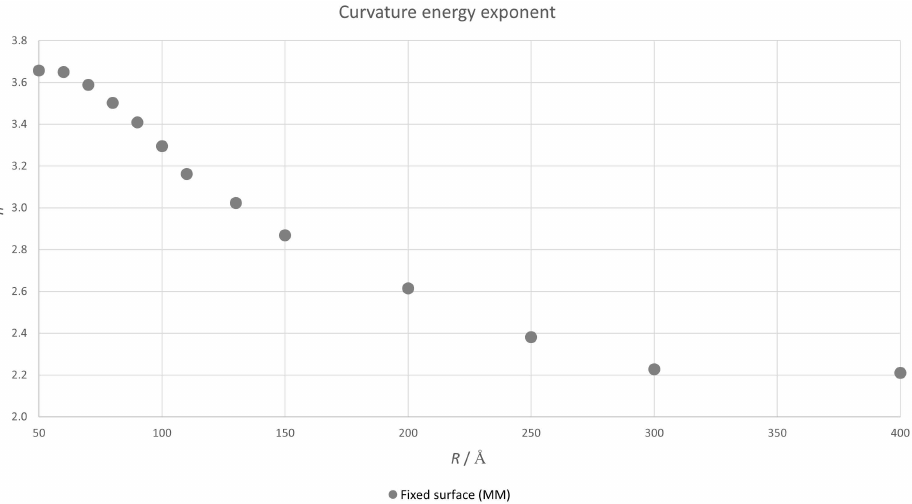
Figure 5. Value of n in Equation (2) as a function of the radius of the spherical carbon nanoflake calculated with the hybrid MM/DFT